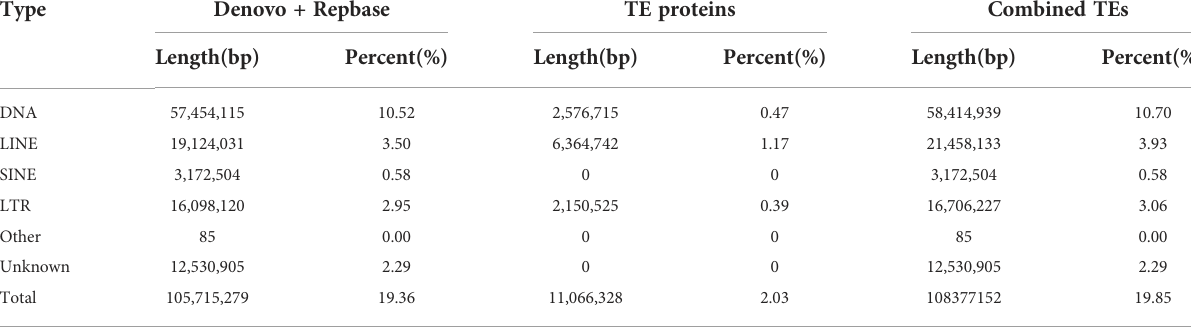
TABLE 3 Summary statistics of the identi fi ed repeat sequences.